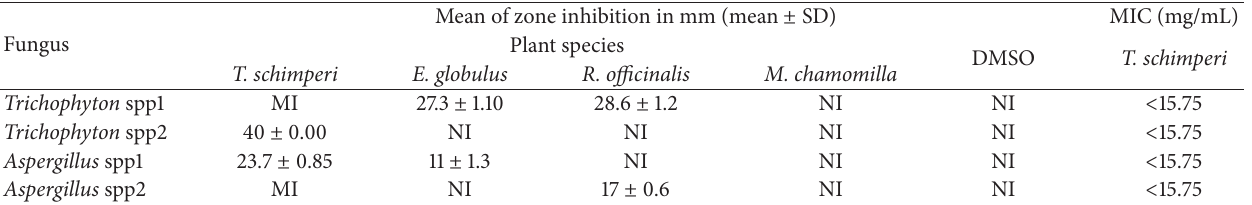
Table 3: Antimicrobial activity of the E. globulus , Matricaria chamomilla , T. schimperi , and Rosmarinus officinalis essential oil against fungi. Mean of zone inhibition in mm (mean ± Fungus